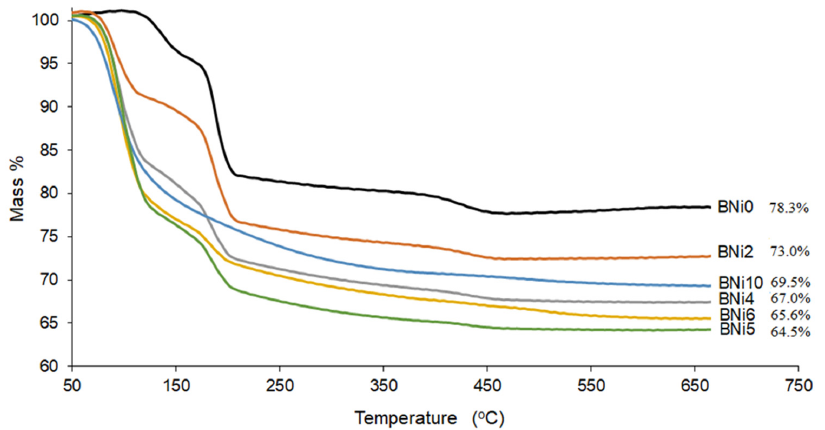
Figure 7. TG curves of Ca x Ni 1-x HPO 4 ·nH 2 O compounds (product names Bni0–Bni10). The brushite dehydration reaction is provided in Equation (2), while the formation of calcium pyrophosphate is described in Equation (3).